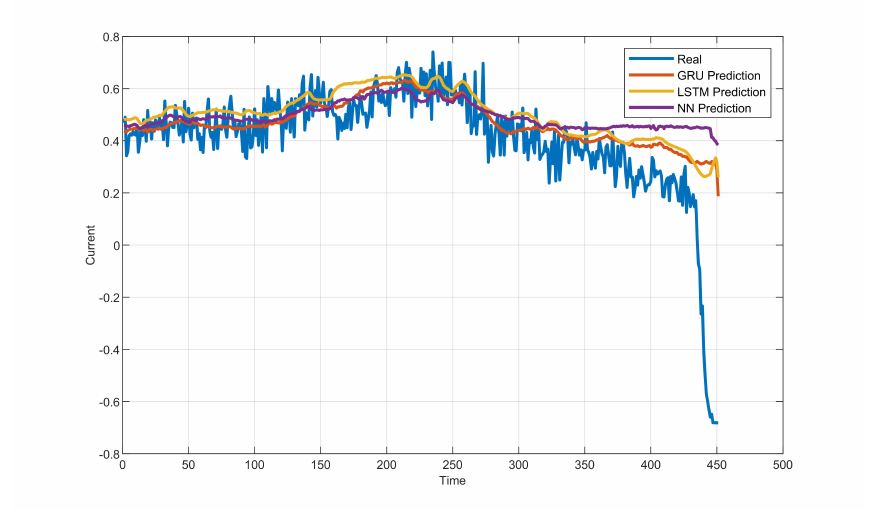
Figure 9. Schematic of experiment